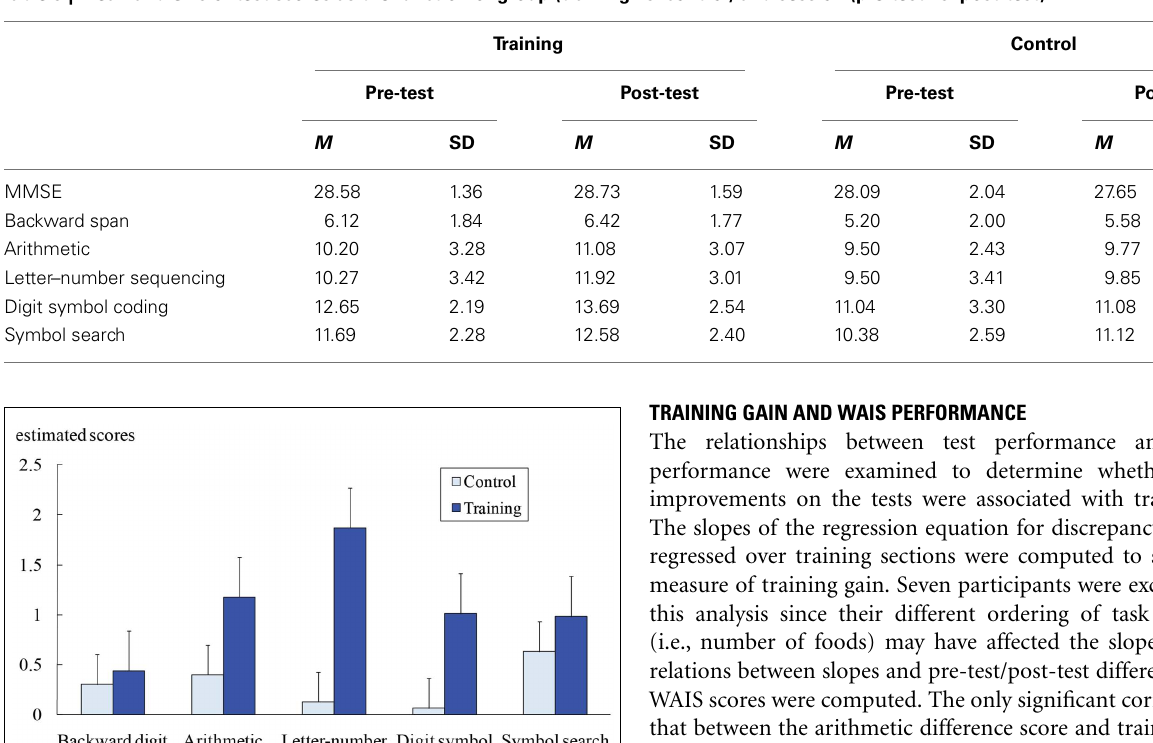
Table 3 | Mean and SDs of test scores as the function of group (training vs. control) and session (pre-test vs. post-test).